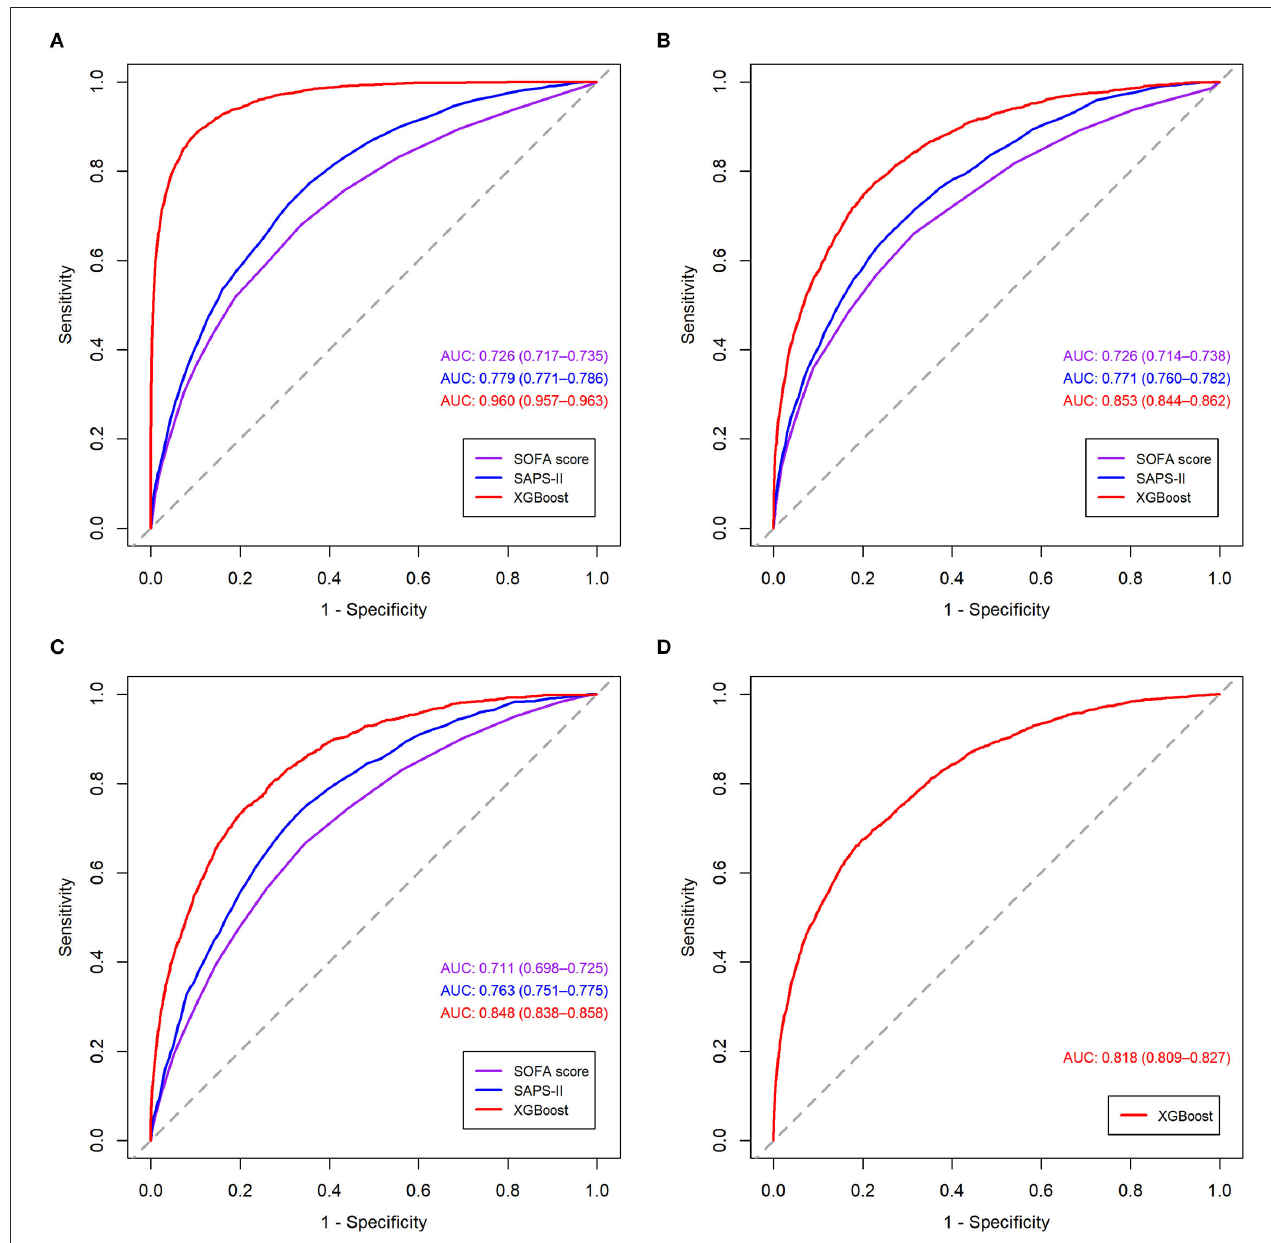
FIGURE 2 | Receiver operating characteristic curves of the models for mortality in the following 48h in the training set. (A) validation set; (B) internal test set; (C) external test set; (D) SOFA, sequential organ failure assessment; SAPS-II, simplified acute physiology score II; XGBoost, extreme gradient boosting.